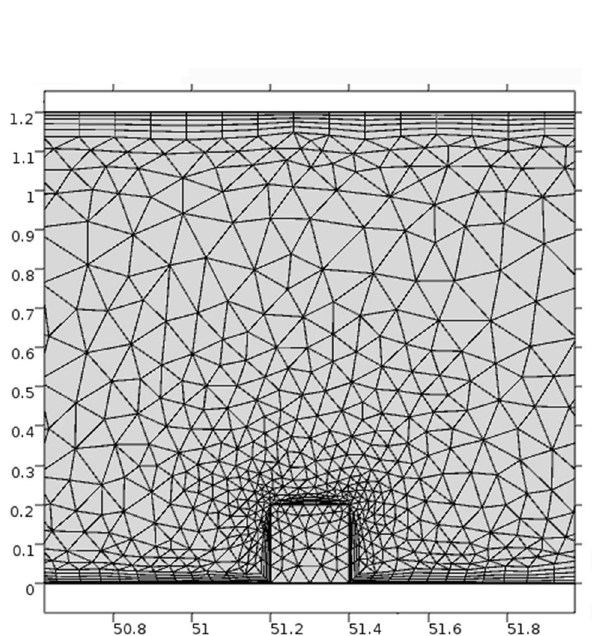
Fig. 6 Adopted different mesh sizes inside the simulated rib-rough- ened narrow channel